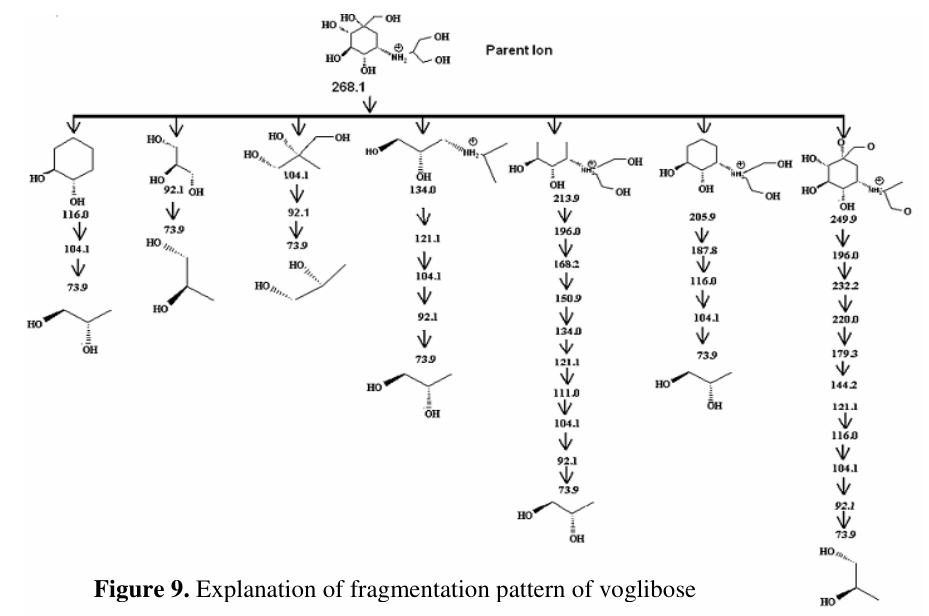
Figure 9. Explanation of fragmentation pattern of